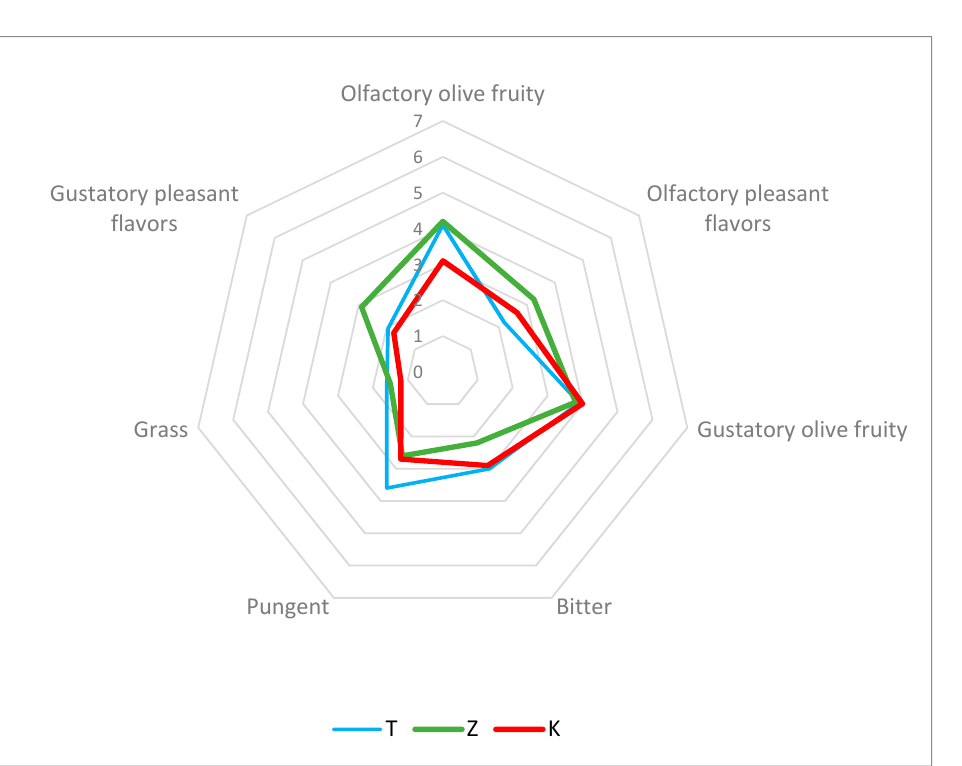
Figure 8. Pleasant flavors of olive oils produced by plants treated with CHA-zeolitite (Z), Kaolin (K) and untreated plants (T). 4. Conclusions In the scenario of sustainable and environmentally friendly olive oil production, both treatments represent valid alternatives to chemical insecticide. From an economic point of view, CHA-zeolitite represents an advantage because the recommended application rate is five times lower than that commonly used for kaolin. Moreover, CHA-zeolitite volcanic rocks abound in Central Italy and are already exploited for several purposes, including the production of micronized powder from the granular material resulting from building